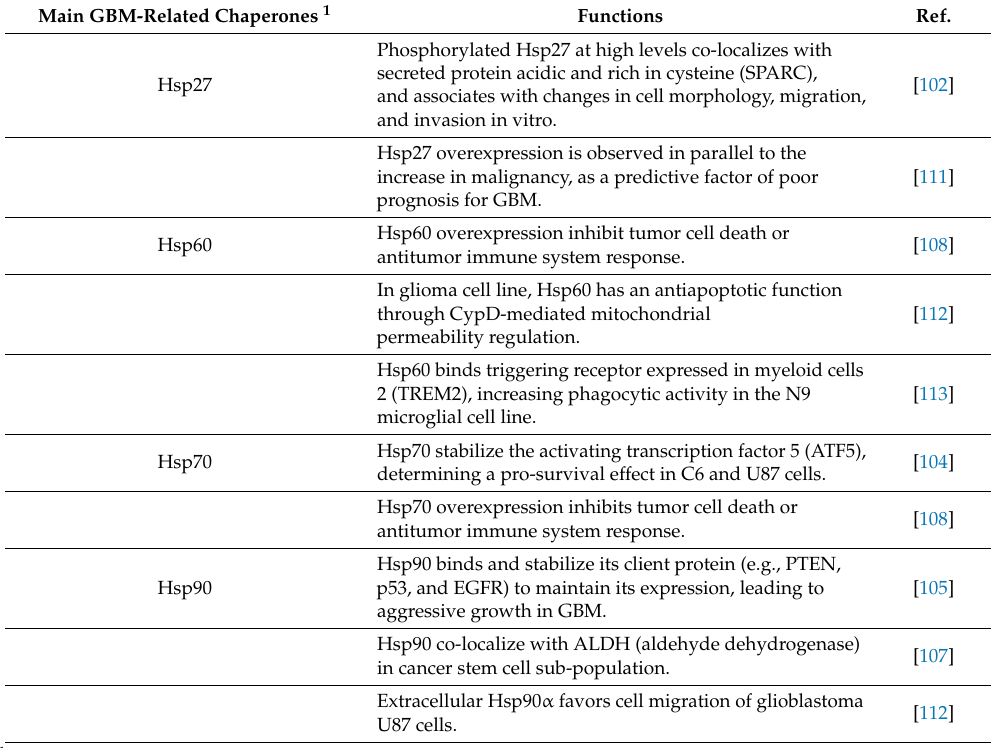
Table 1. Involvement of molecular chaperones in glioma genesis and